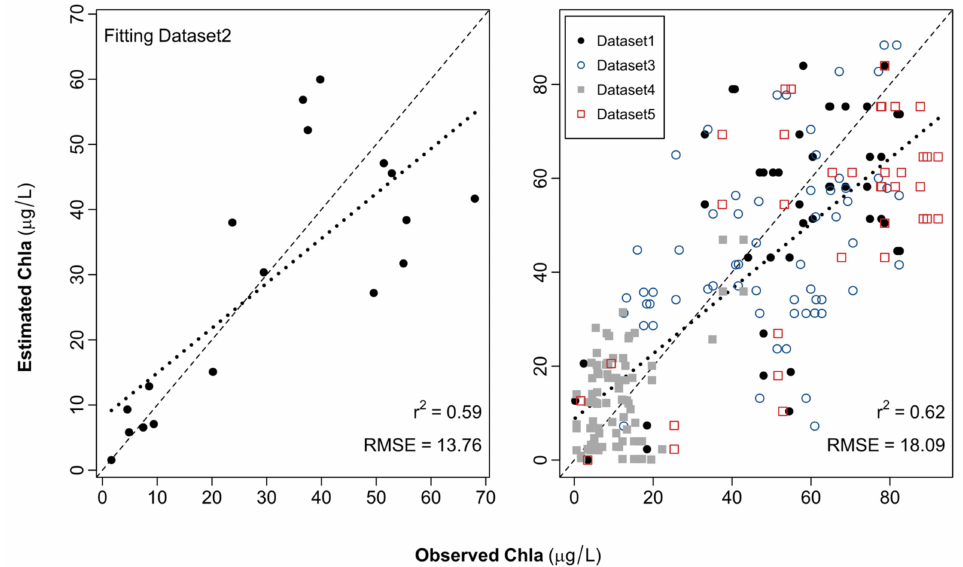
Figure 3. The selected model (#1, Table 4) for chlorophyll-a (chla) estimation from the MODIS images. The model was fitted with field reflectance data and chla data from Dataset 2 and validated with the remaining datasets and with reflectance data from the MODIS images of the same day of the chla data. The dashed lines illustrate the 1:1 ratio and the dotted ones are the line of best